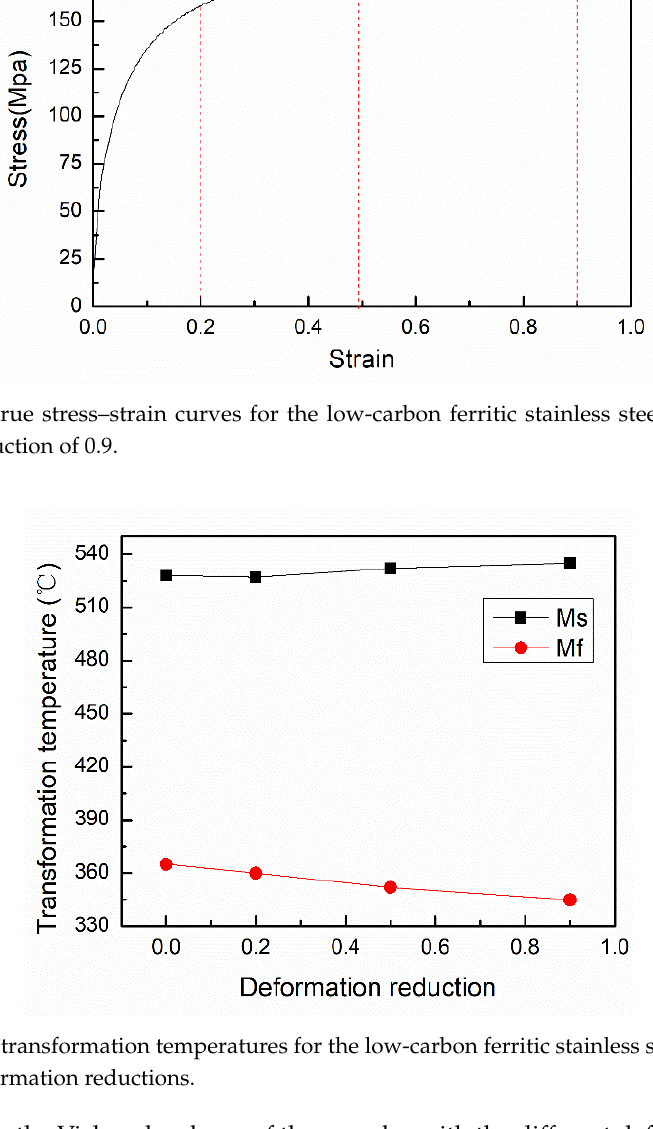
Figure 14. Vickers hardness of the low-carbon ferritic stainless steel samples with the different deformation reductions.